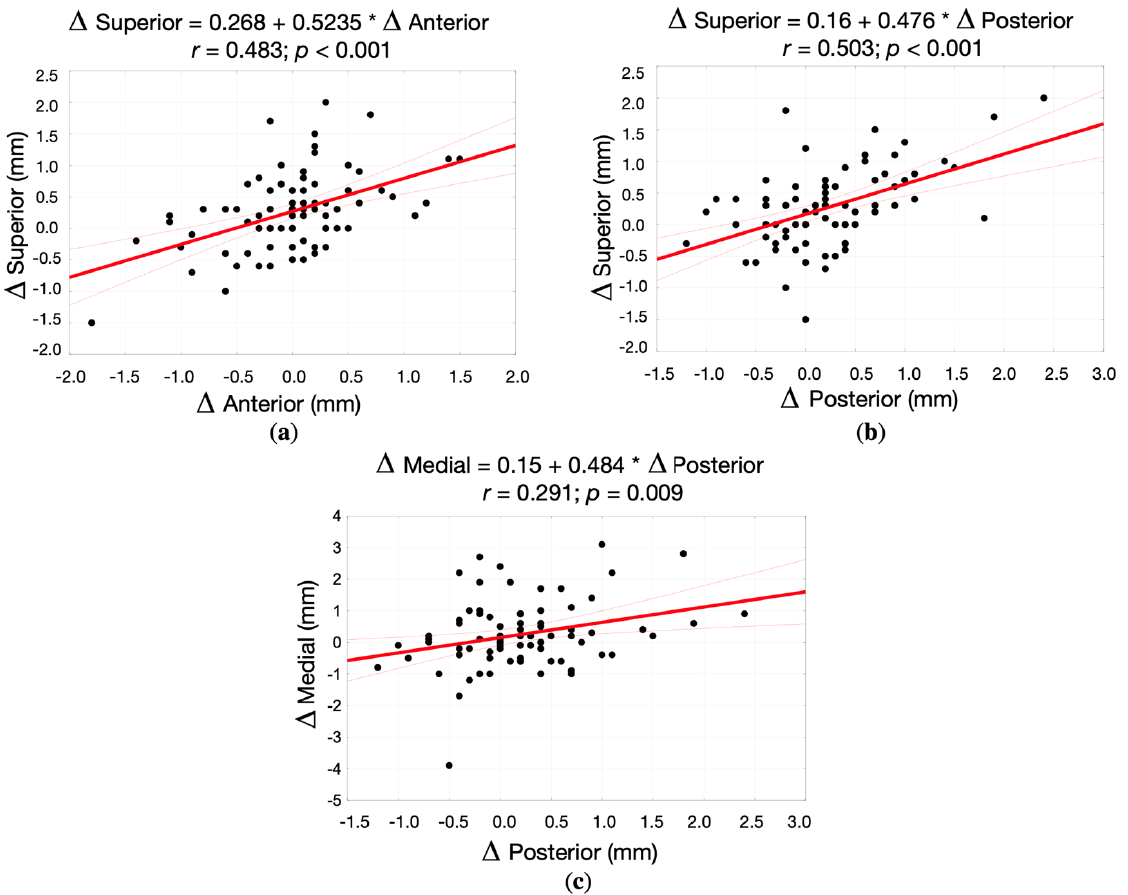
Figure 8. The correlation between the changes in the dimension of different joint spaces in all (right and left) TMJs (correlation diagrams, correlation coefficient, and regression straight line equation) in the study group: ( a ) Superior vs. Anterior joint spaces; ( b ) Superior vs. Posterior joint spaces; ( c ) Medial vs. Posterior joint spaces.